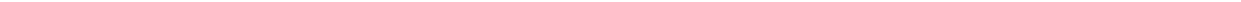
Fig. 4 RNA-Seq analysis on C9ORF72 mutant MNs. a Heat map and dendrogram depicting hierarchical clustering of RNA sequencing reads from controls (Con-1, Con-2), C9ORF72 mutant (C9-1, C9-3), and C9-3 Δ MNs. b Venn diagram depicting identi fi cation of differentially expressed genes between two mutant C9ORF72 MNs and control MNs. Central intersect represents 165 dysregulated genes compared to both control and gene-corrected MNs. c Scatter plot showing comparison of transcriptome reads of two independent C9ORF72 mutant MNs and C9-3 Δ MNs to controls. Red crosses denote signi fi cantly upregulated genes and blue crosses denote signi fi cantly downregulated genes ( p < 0.05, analysis performed using DESeq2). These dysregulated genes in C9ORF72 mutant MNs are reversed to control levels in C9- Δ MNs. d , e Graph depicting the spread of differentially regulated, upregulated ( d ), and downregulated ( e ) genes in mutant C9ORF72 MNs, red star denotes the levels of GluA1. f , g Gene ontology studies on upregulated ( f ) and downregulated genes ( g